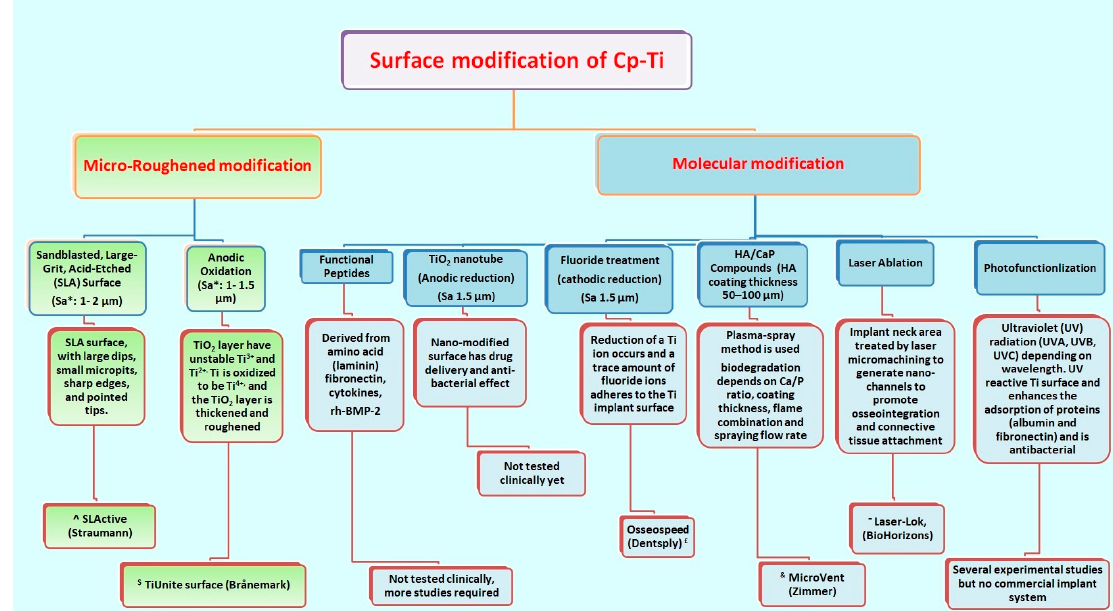
Figure 6. Schematic presentation of surface modification of grade IV commercially pure titanium (cp-Ti). * Sa (the arithmetic mean height of the surface), ˆ SLActive (Straumann Institute AG, Basel, Switzerland), $ TiUnite surface (Brånemark System, Nobel Biocare, Göteborg, Sweden), £ Osseospeed (Astra Tech, Dentsply, Waltham, MA, USA), & MicroVent (Zimmer Dental, Carlsbad, CA, USA), = Laser-Lok (BioHorizons, Birmingham, AL, USA).